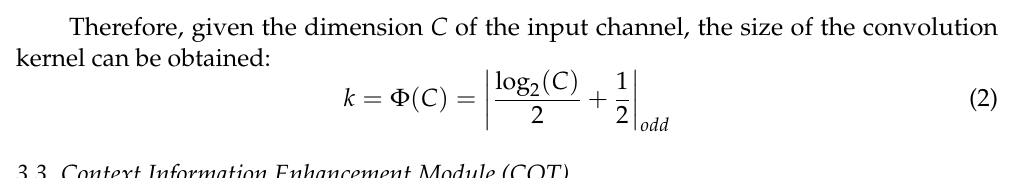
Figure 9. ECA module structure.